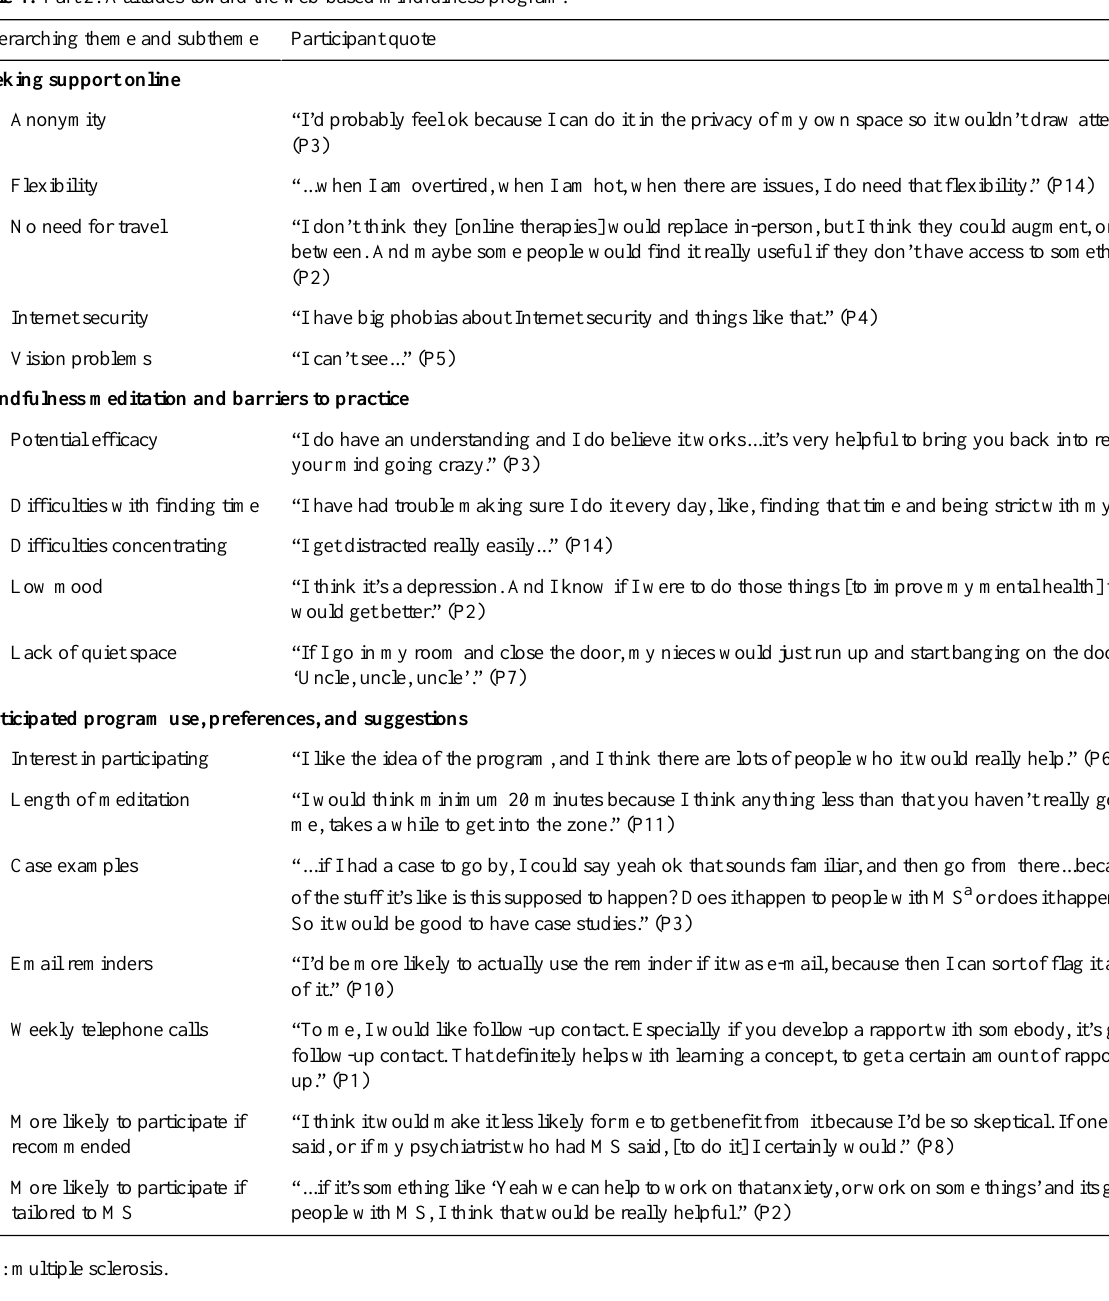
Table 4. Part 2: Attitudes toward the web-based mindfulness program.